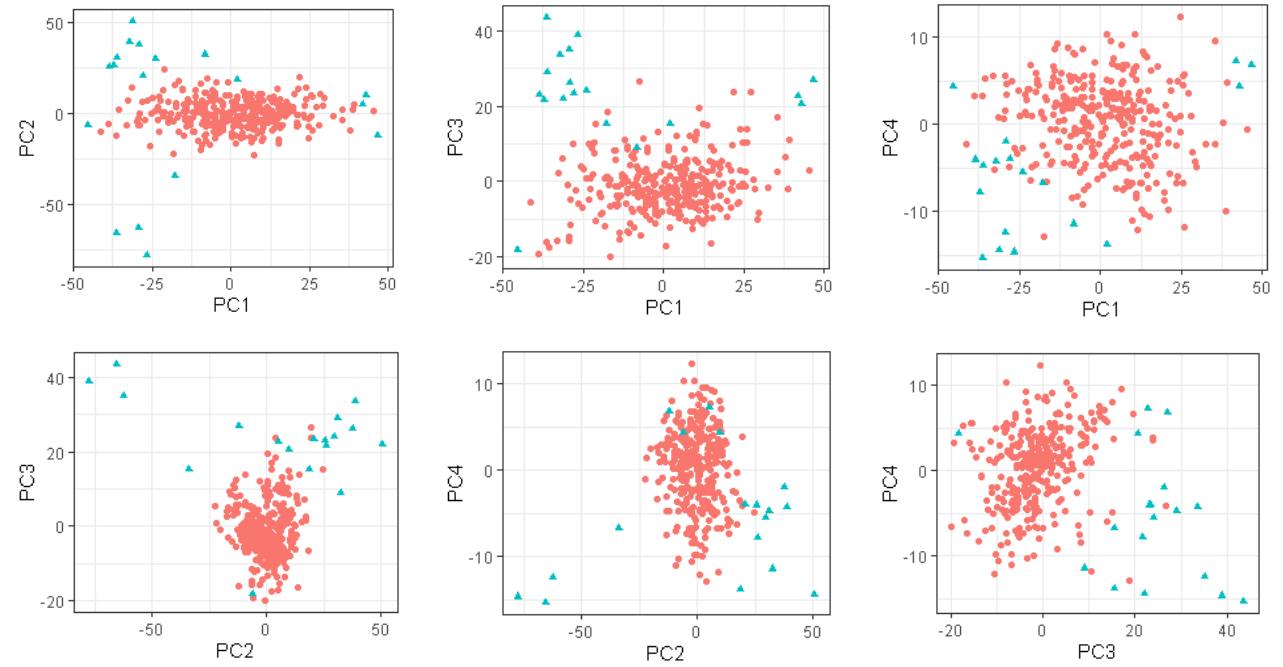
Figure 2. Spectra in the centre ( ) and on the edge ( ) (the 5% greatest Mahalanobis distance from the centre, of the four-dimensional principal component space of standardised spectra.